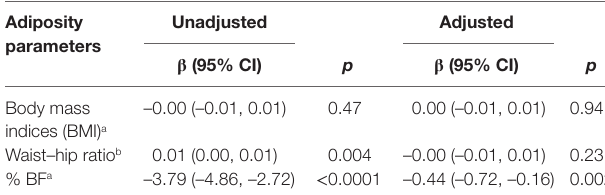
TaBle 2 | Association of physical activity (Physical Activity Questionnaire for Older Children scores) and adiposity parameters presented as β with 95% confidence interval (CI) and p -value.